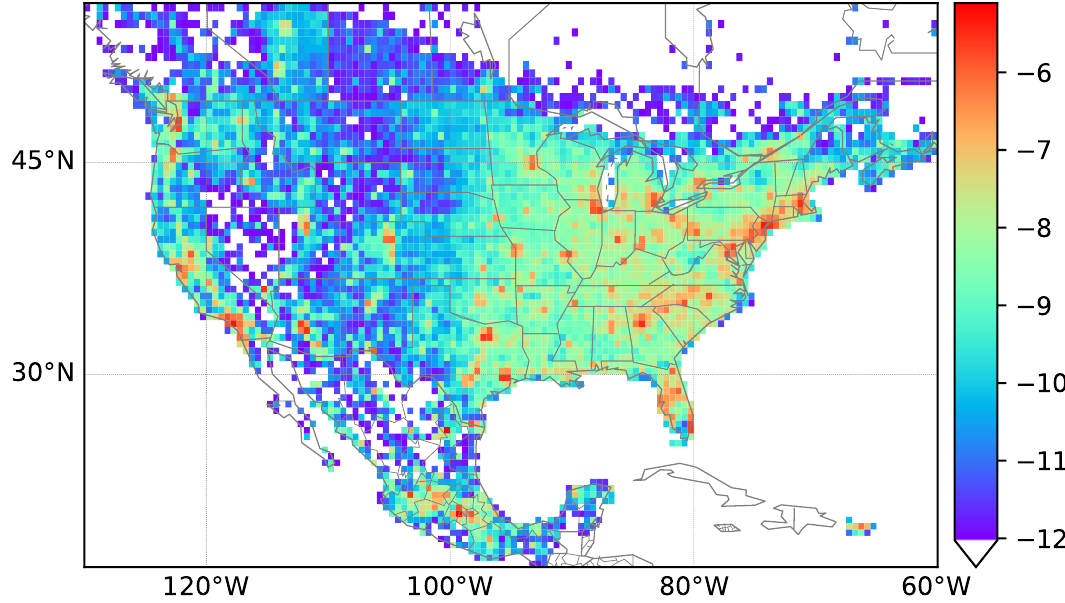
Figure 3. Heatmap of North America showing the density of streets. Colors indicate the density of streets in this area, thus the logarithmic normalized number of streets per cell of the grid. Higher values and red colors show a higher density of streets. Each cell c ij covers an area of 0.5 ◦ in longitude and latitude, for which we count the number of streets n ij intersecting the